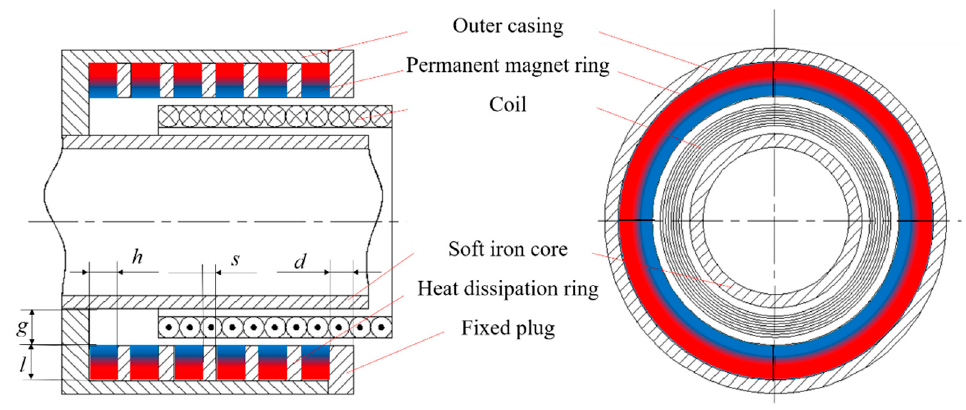
Figure 4. The inner structure of the actuator.